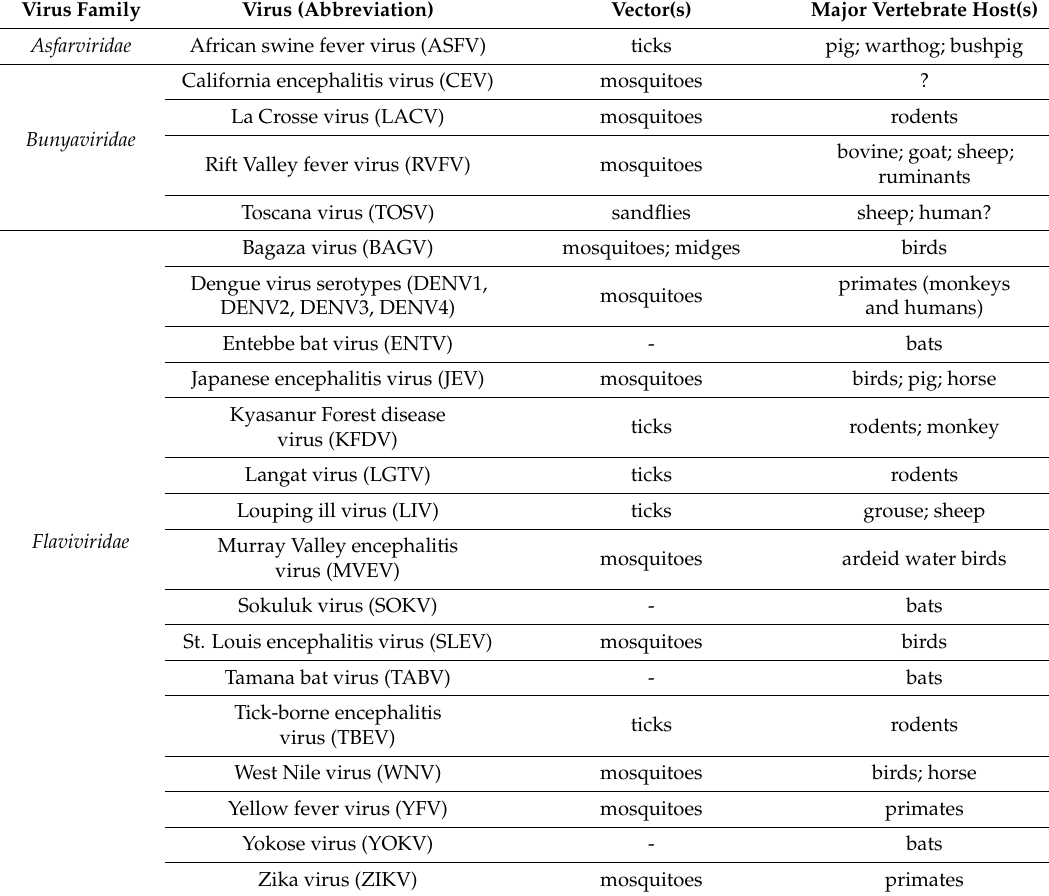
Table 1. A list of vector–host relations of the arboviruses and related viruses